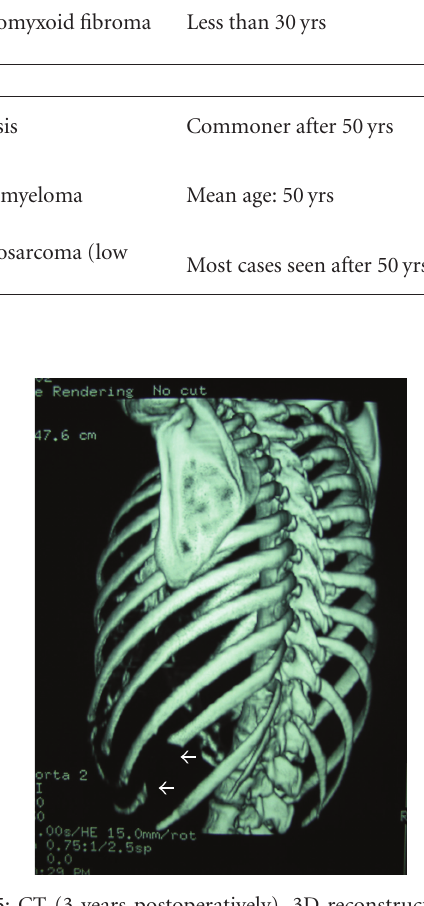
Figure 5: CT (3 years postoperatively), 3D reconstruction of the thoracic skeleton, showing the surgical defect at the middle part of the left 10th rib